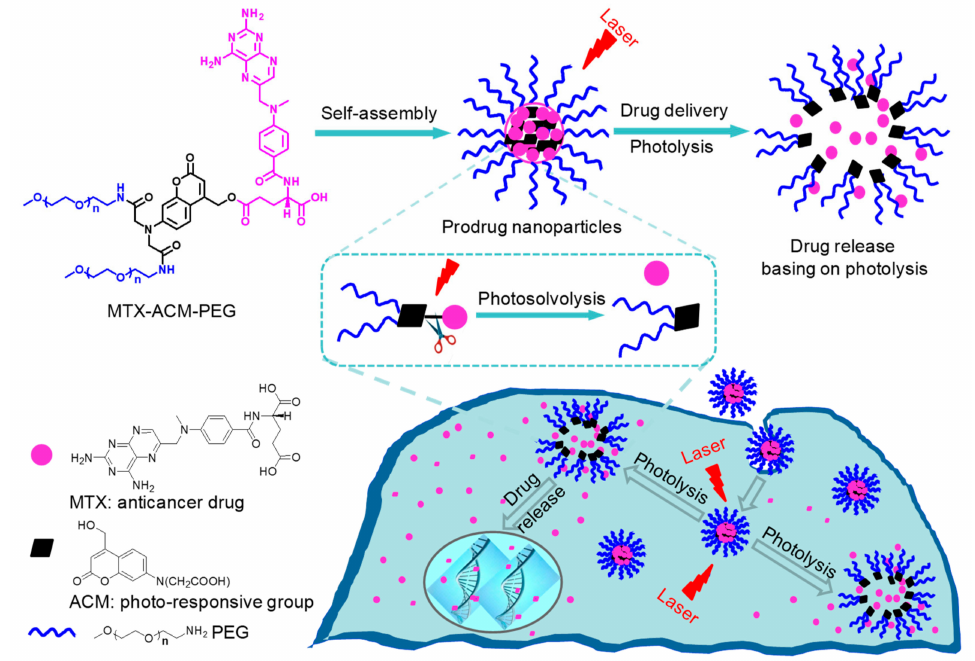
Figure 1. The self-assembly of methotrexate-coumarin derivative-PEG (MTX-AMC-PEG) conjugate prodrug into nanoparticles with photoresponsive release via